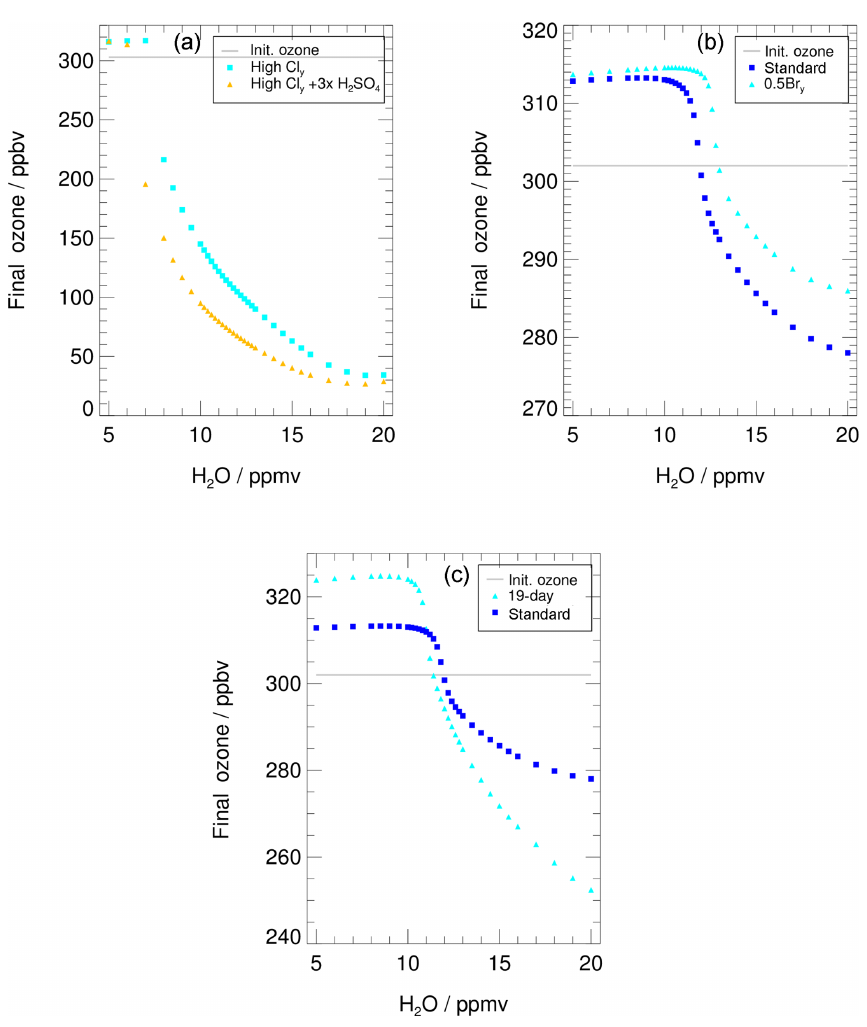
Figure 11. The water-dependent final ozone value is shown for (a) the “case of high Cl y ” (see Table 1 for NO y and Cl y initialization) assuming background aerosol (light blue) and tripled H 2 SO 4 (yellow), (b) reduced Br y (light blue, “Reduced Br y case”), and (c) an extended time period of activated chlorine (light blue, “19d simulation”). In panel (b) and (c) final ozone of the standard case is also shown (blue). Initial ozone is marked with a grey line. Note that the scales of all y axes